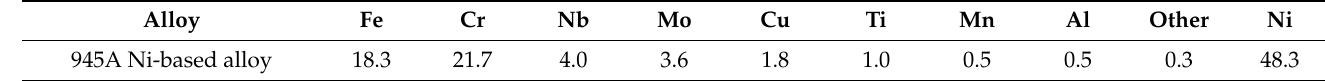
Table 1. The chemical composition of the 945A Ni-based alloy.